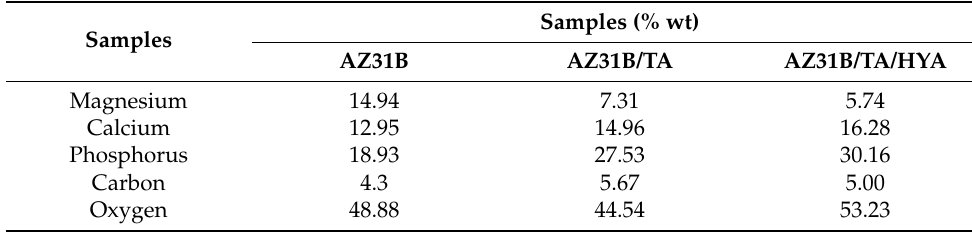
Table 7. EDS results of samples AZ31B, AZ31B/TA, and AZ31B/TA/HYA after seven days SBF immersion test.